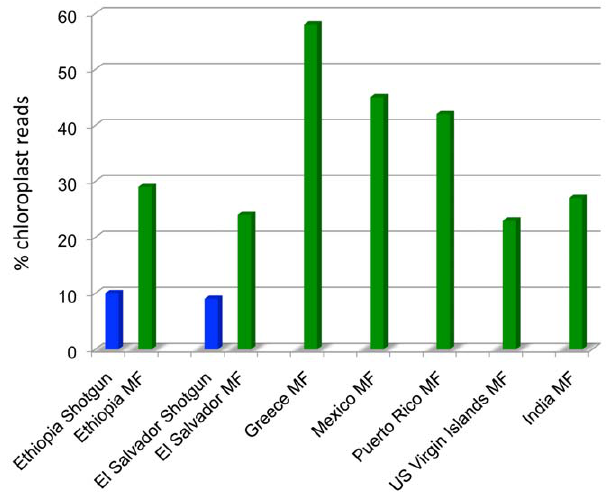
Figure 2. Chloroplast read enrichment in methylation filtration libraries. Percentage of chloroplast reads in each shotgun (blue) or MF (green) library. Available shotgun reads for cultivars from Ethiopia and El Salvador are shown to highlight the enrichment in chloroplast sequences in MF libraries.